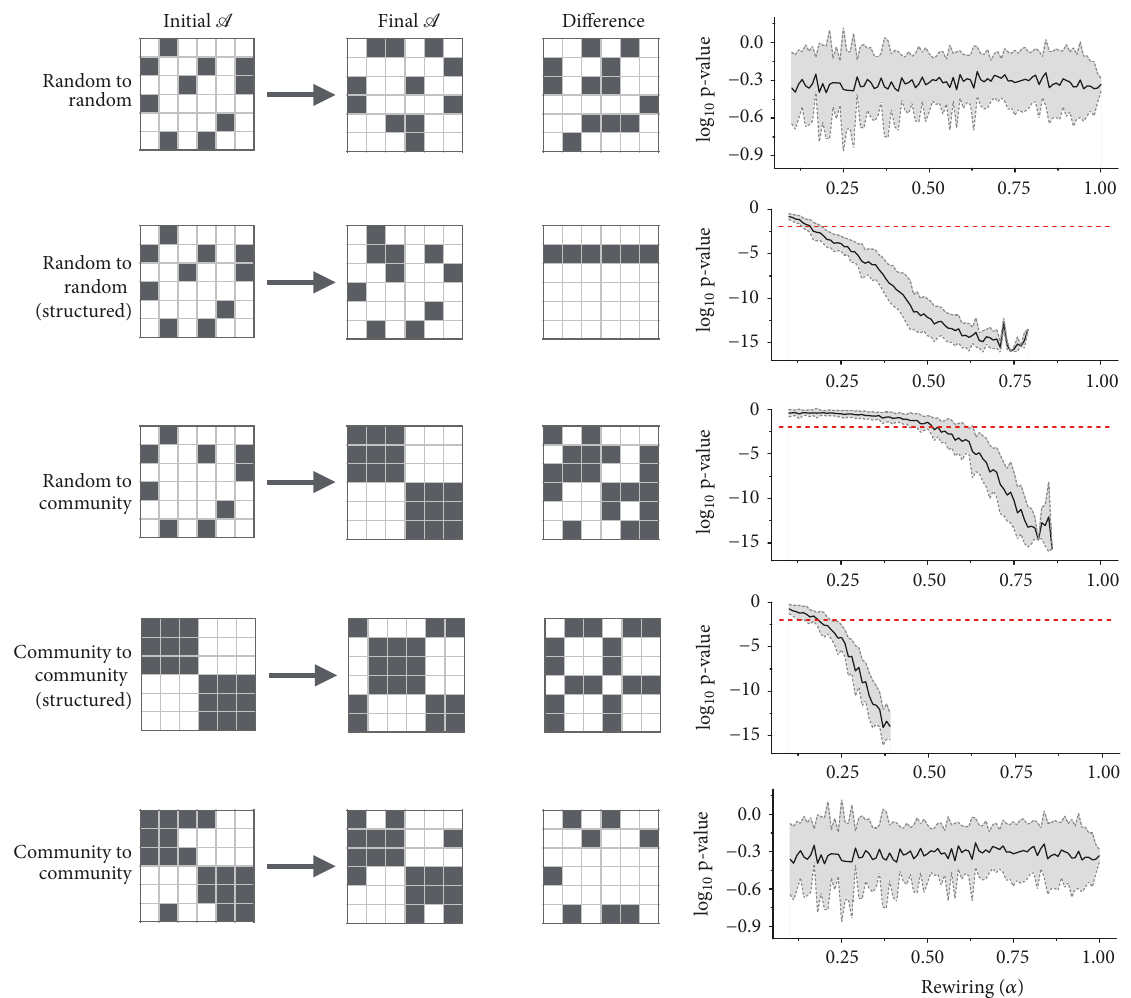
Figure 1: Examples of the application of the proposed algorithm to synthetic evolving networks. From left to right, the four columns, respectively, represent the initial adjacency matrix; the final adjacency matrix; the difference matrix; and the evolution of the log 10 of the 𝑝 -value of the test assessing the presence of a structured change, as a function of the rewiring 𝛼 ; see main text for details. All calculations have been executed with 100 -nodes networks, while the depicted adjacency matrices have a smaller size for the sake of clarity. The black line and grey bands on the right hand side, respectively, depict the average and 1𝜎 band, as obtained in 100 random